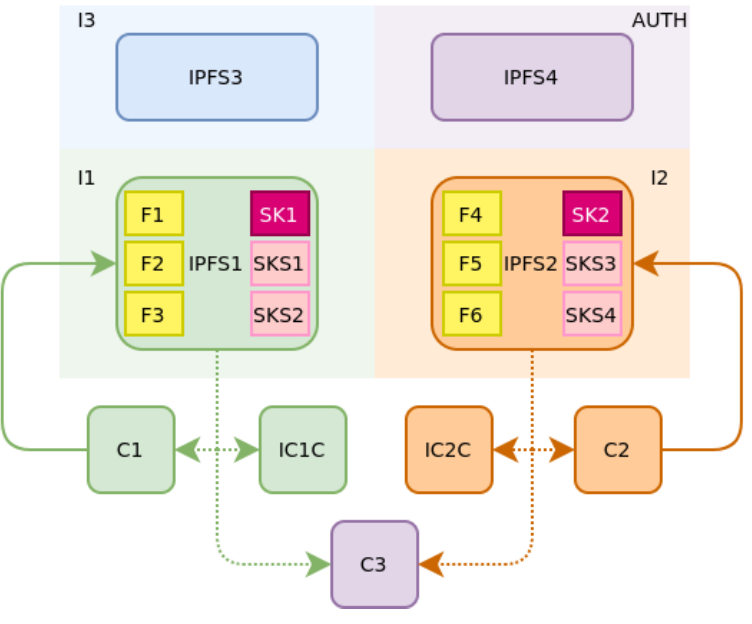
Figure 7. IPFS network